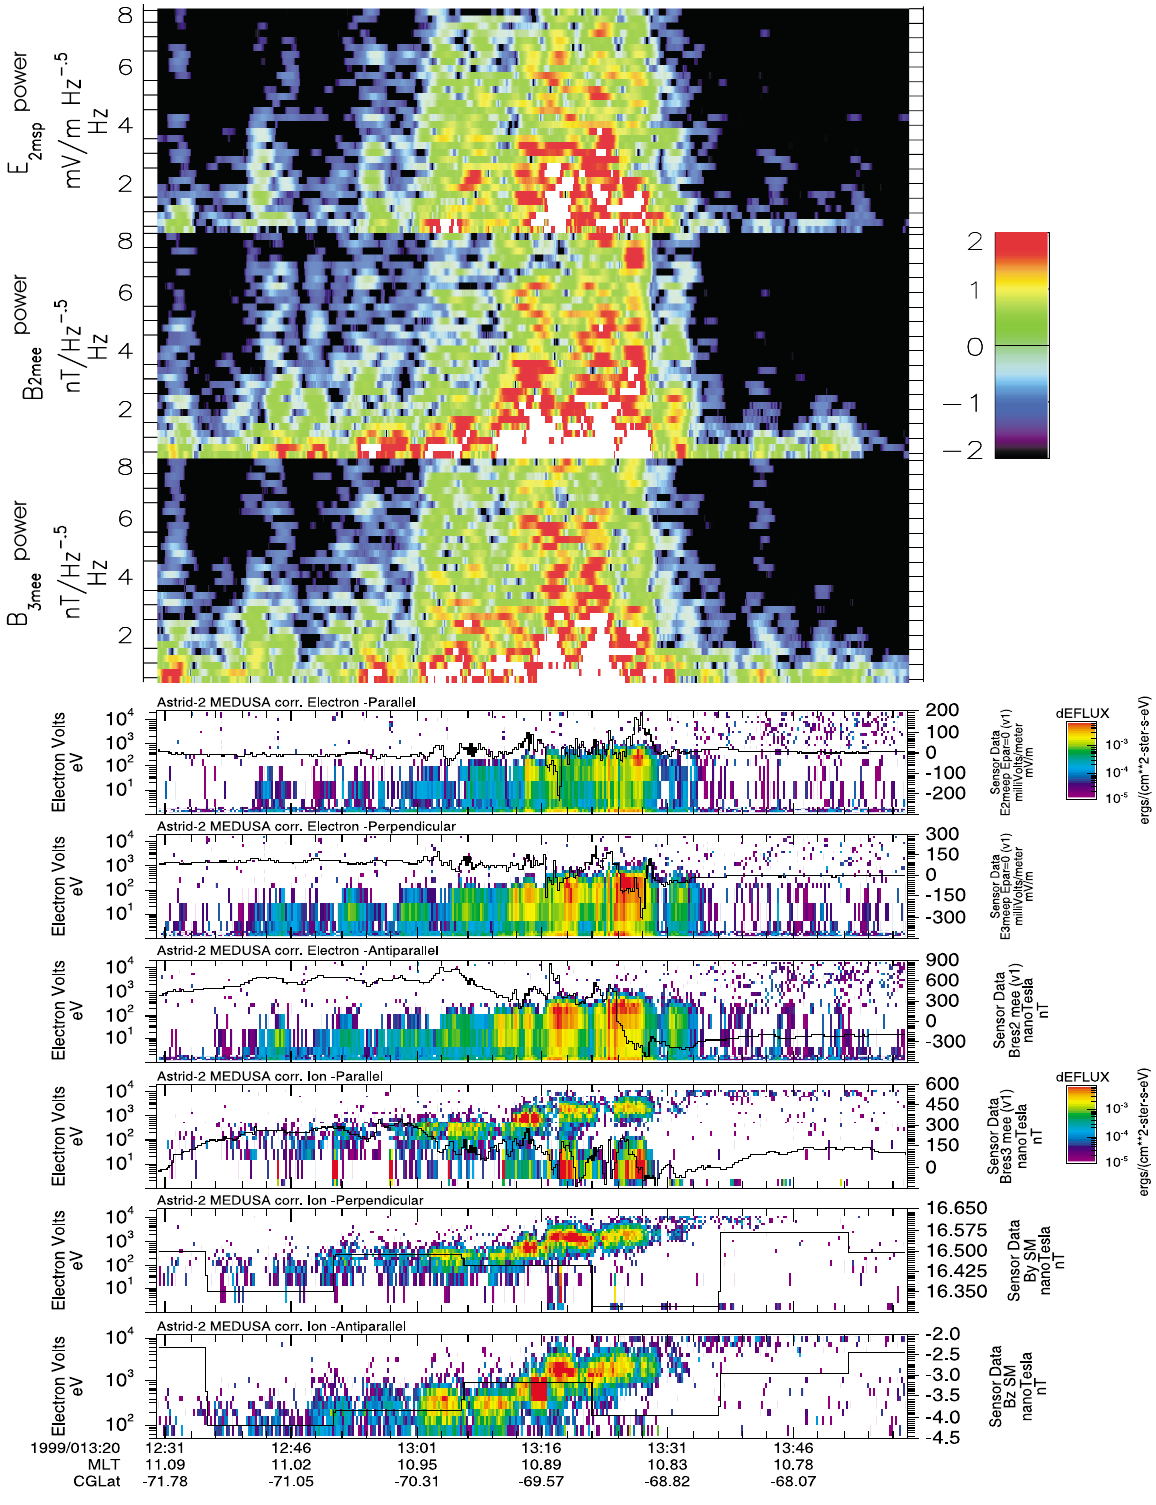
Fig. 2. Astrid-2 data from 13 January 1999 with a dispersion signature and equatorward V similar to DE-2. Top spectrogram is electric field wave power up to 8 Hz. The second and third panels are delta magnetic field wave power. The middle three spectrograms are electrons in the parallel, perpendicular, and antiparallel directions, respectively. The bottom three spectrograms are for the same three look directions for the ions. The line plots in the fourth and fifth panels are electric field calculated for the eastward and equatorward directions, assuming E is zero along the magnetic field. The two panels below it contain delta magnetic field data for the same two directions. The bottom two panels contain the IMF in the y and z directions as measured by